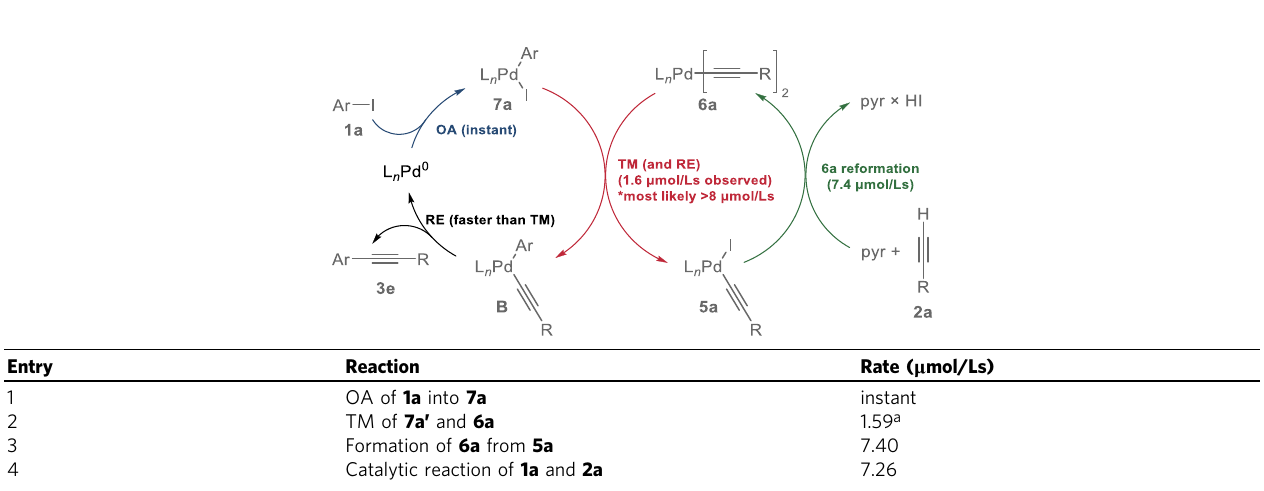
Table 1 Comparison of the rates of isolated elementary steps with the catalytic reaction between 1aand